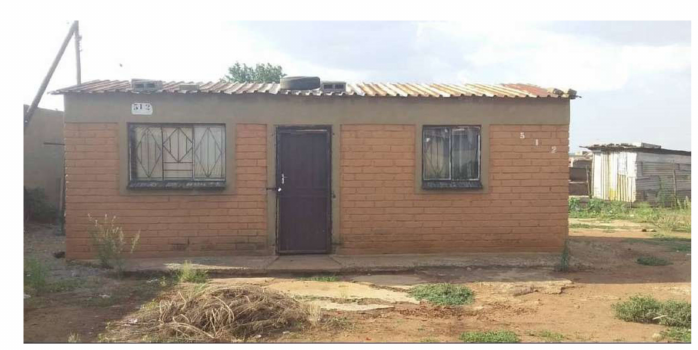
Figure 3. An archetypal Kathorus apartheid era- matchbox- house constructed in the early 1960s, housing between one to six occupants. The houses were typically 40 m 2 in area, and were constructed with low-grade clay brick. The houses either had corrugated or asbestos roofing, and four windows (two in the front and two at the back).